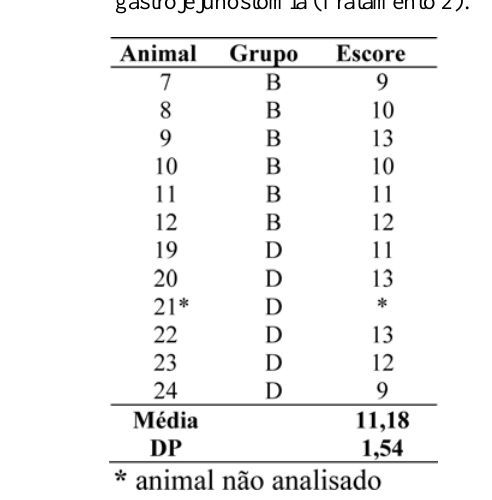
TABELA 6 : Resultados da variável escore (qualidade da cicatrização), referente aos animais